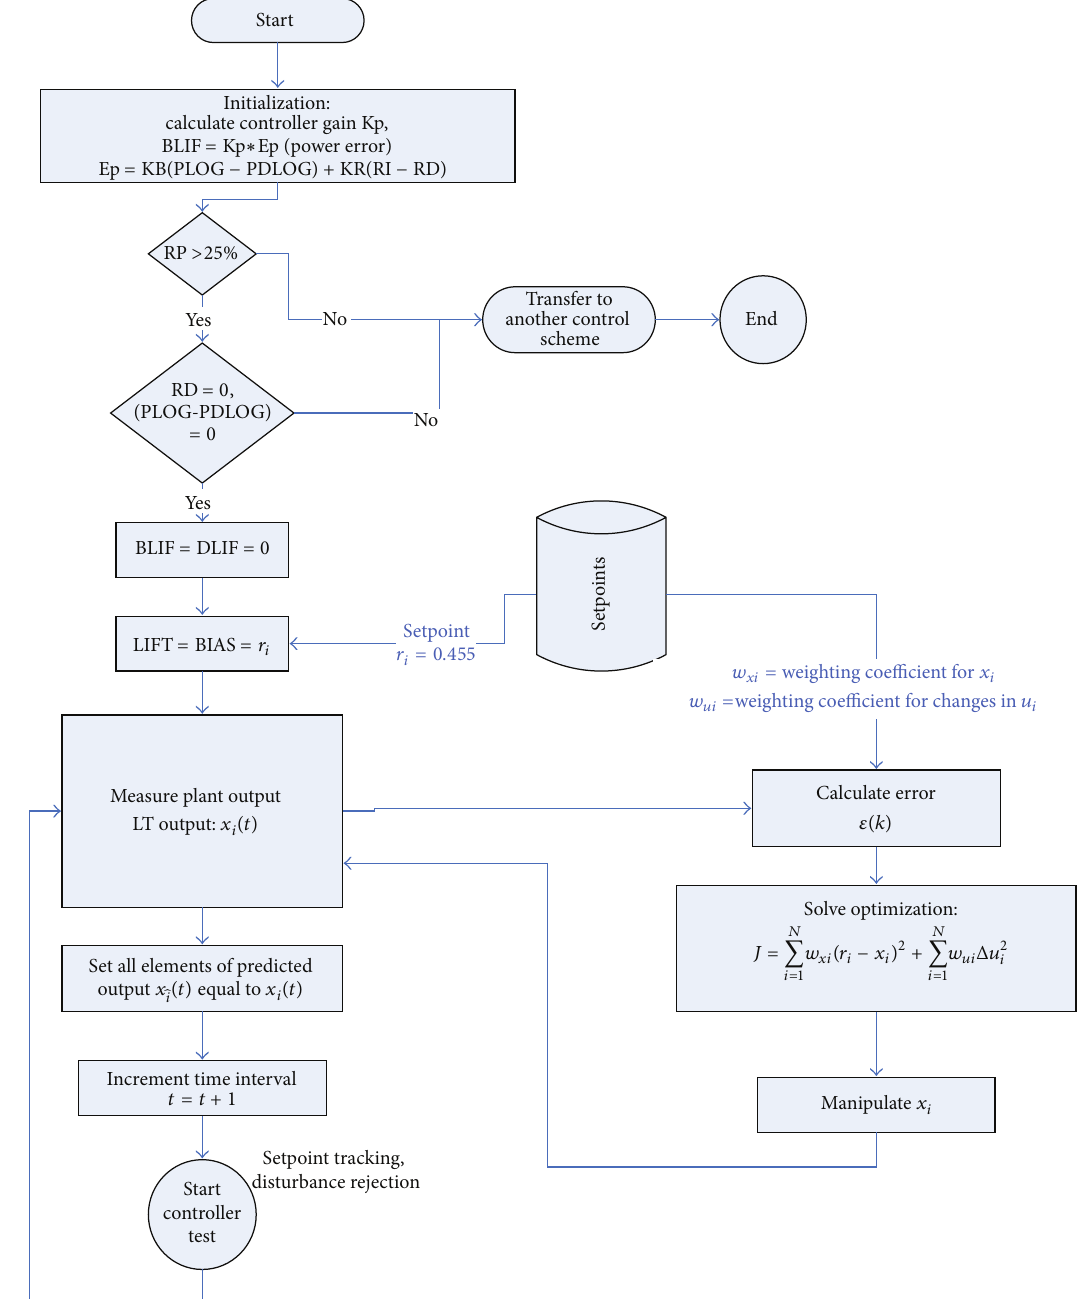
Figure 10: Proposed control design